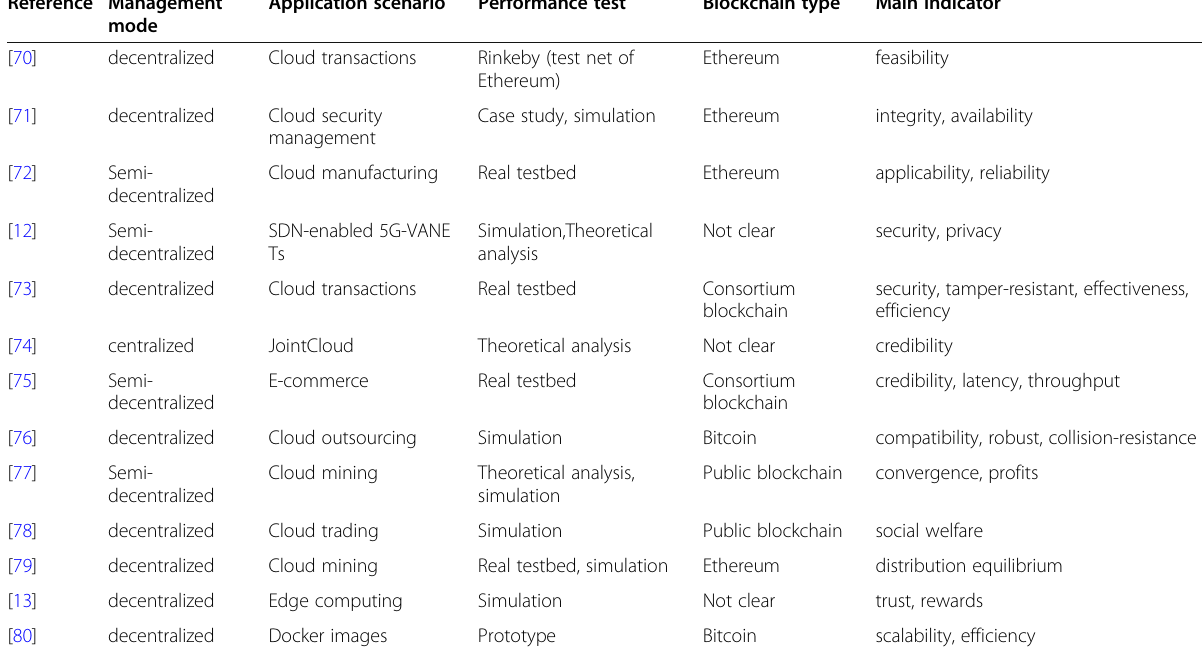
Table 4 Comparison of the applied methodology Reference Management mode